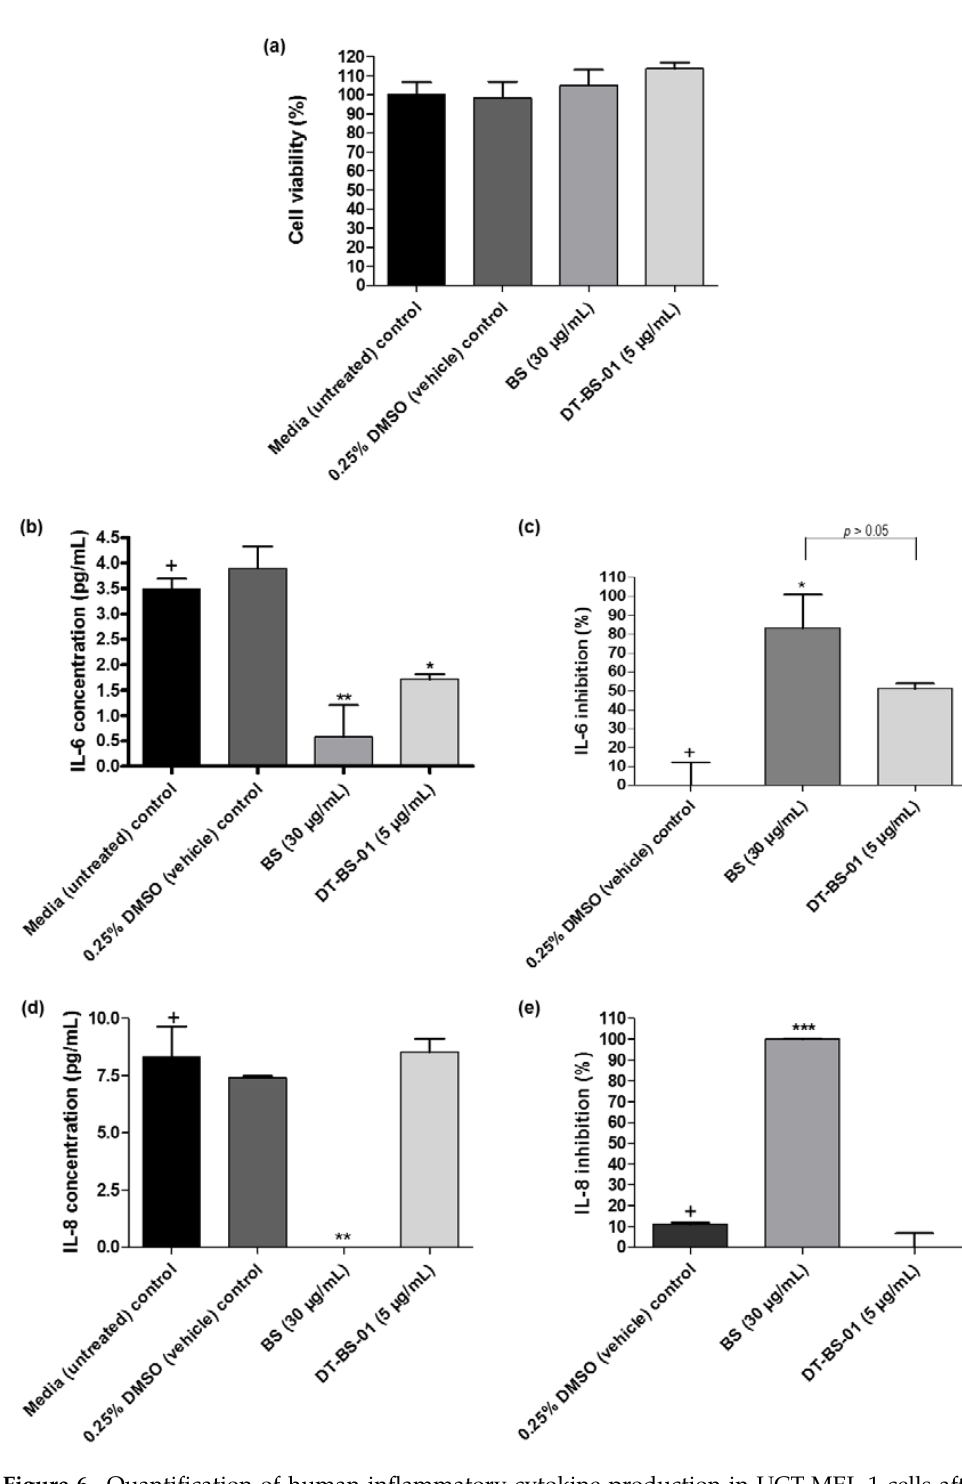
Figure 6. Quantification of human inflammatory cytokine production in UCT-MEL-1 cells after treatment with Buddleja saligna extract (BS: 30 µ g/mL) and isolated triterpenoid mixture (DT-BS- 01: 5 µ g/mL) for 20 h. Controls included the 0.25% DMSO (vehicle) control and cells grown in medium (untreated). ( a ) Percentage cell viability, ( b ) concentration of IL-6 (pg/mL), ( c ) percentage IL-6 inhibition, ( d ) concentration of IL-8 (pg/mL) and ( e ) percentage IL-8 inhibition. Data was expressed as mean ± SD ( n = 2). * p < 0.05, ** p < 0.01 and *** p < 0.001 indicates statistical significance when compared to the control (+). Statistical analysis was done using one-way ANOVA followed by Tukey’s Multiple Comparison